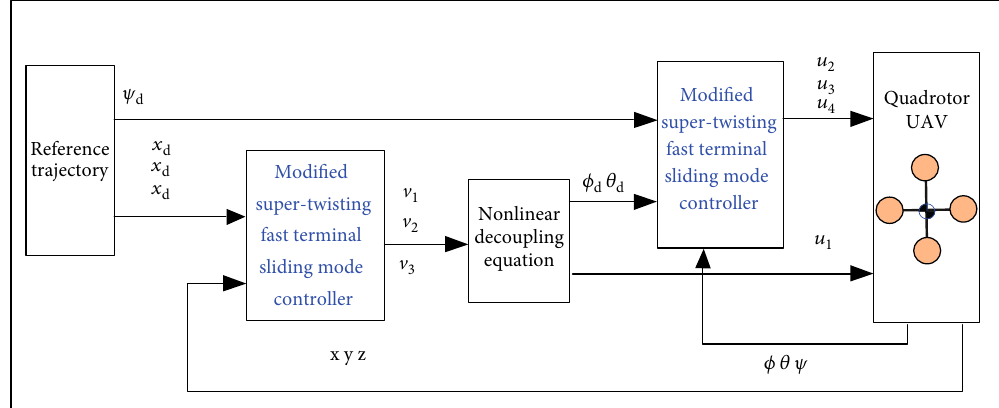
Figure 2: General block diagram for the quadrotor control